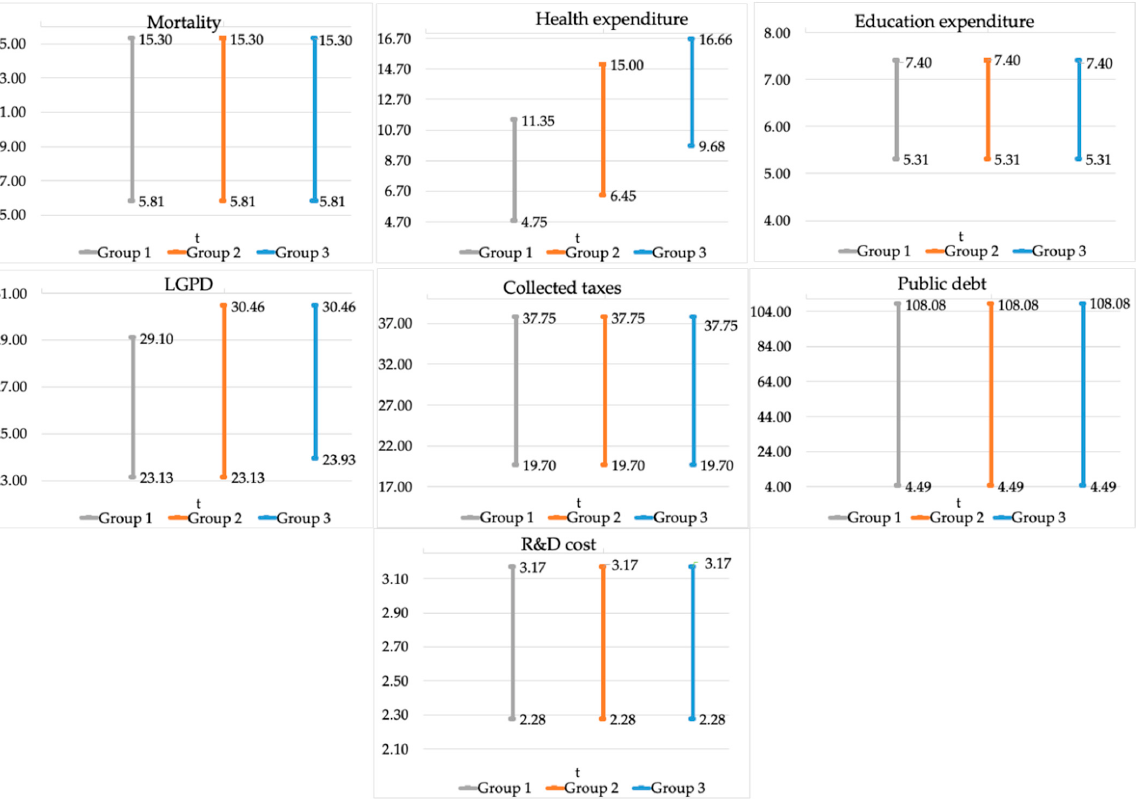
Figure 7. Range of ε -efficient frontier by groups defined by MEs.